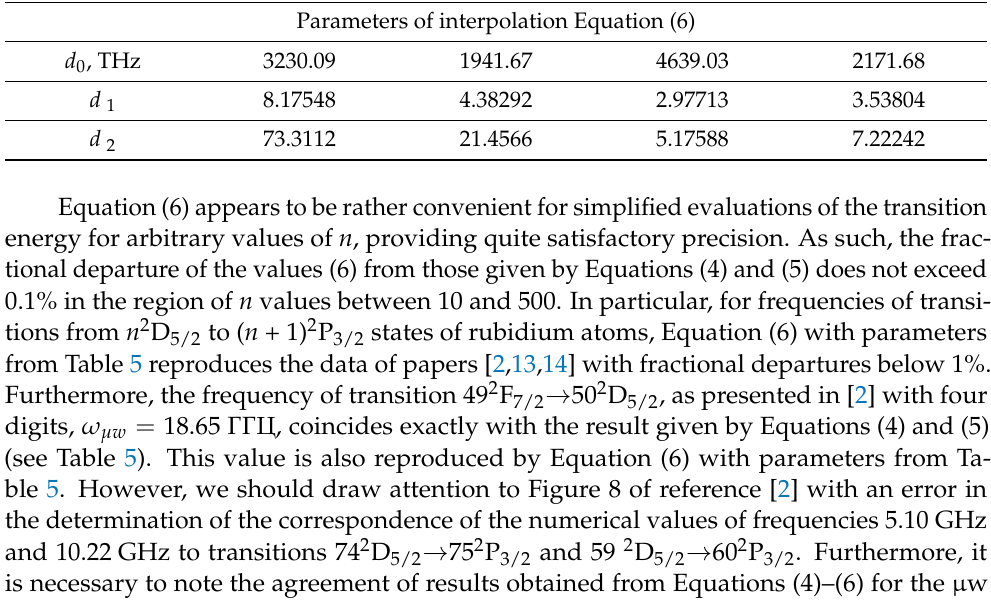
Table 5. Frequencies of electric dipole transitions in Rb atoms: from state n P 3/2 to the n S 1/2 state, ∆ E = E − E n PS n P 3/2 n S 1/2 ; from state n D 5/2 to the ( n + 1 )P 3/2 state, state ( n + 2)P 3/2 to the n D 5/2 state, ∆ E n PD = E ( n + 2 ) P